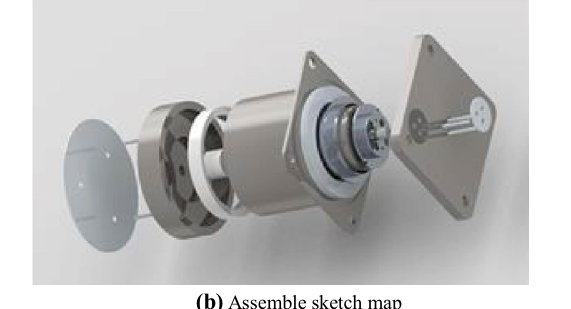
Figure 1 Double push rods electromechanical